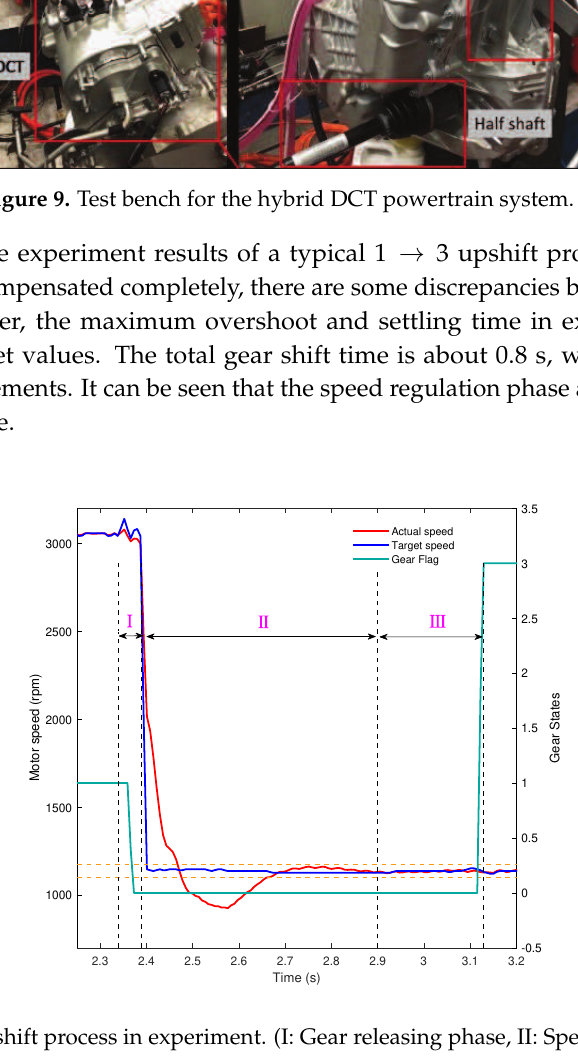
Figure 10. The 1–3 upshift process in experiment. (I: Gear releasing phase, II: Speed regulation phase, III: Gear engagement